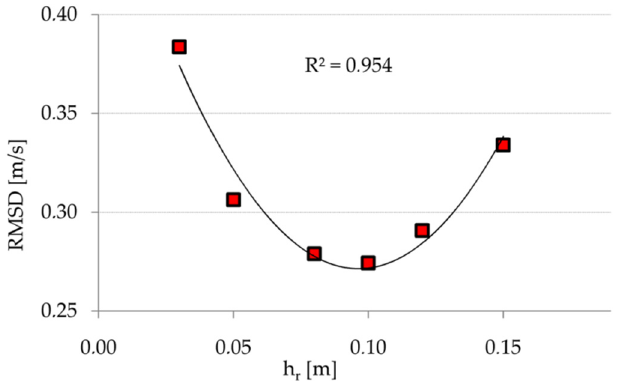
Figure 3. Square regression RSMD~ h r [5].